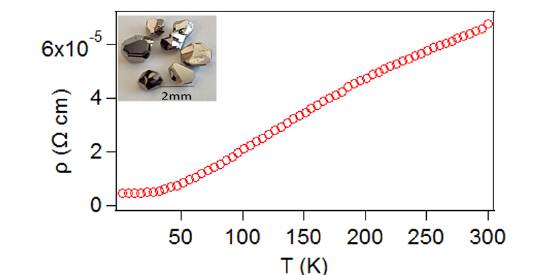
Figure 3. Resistivity vs. temperature of an unoriented crystal of NbP. Single crystals of NbP are shown in the inset.